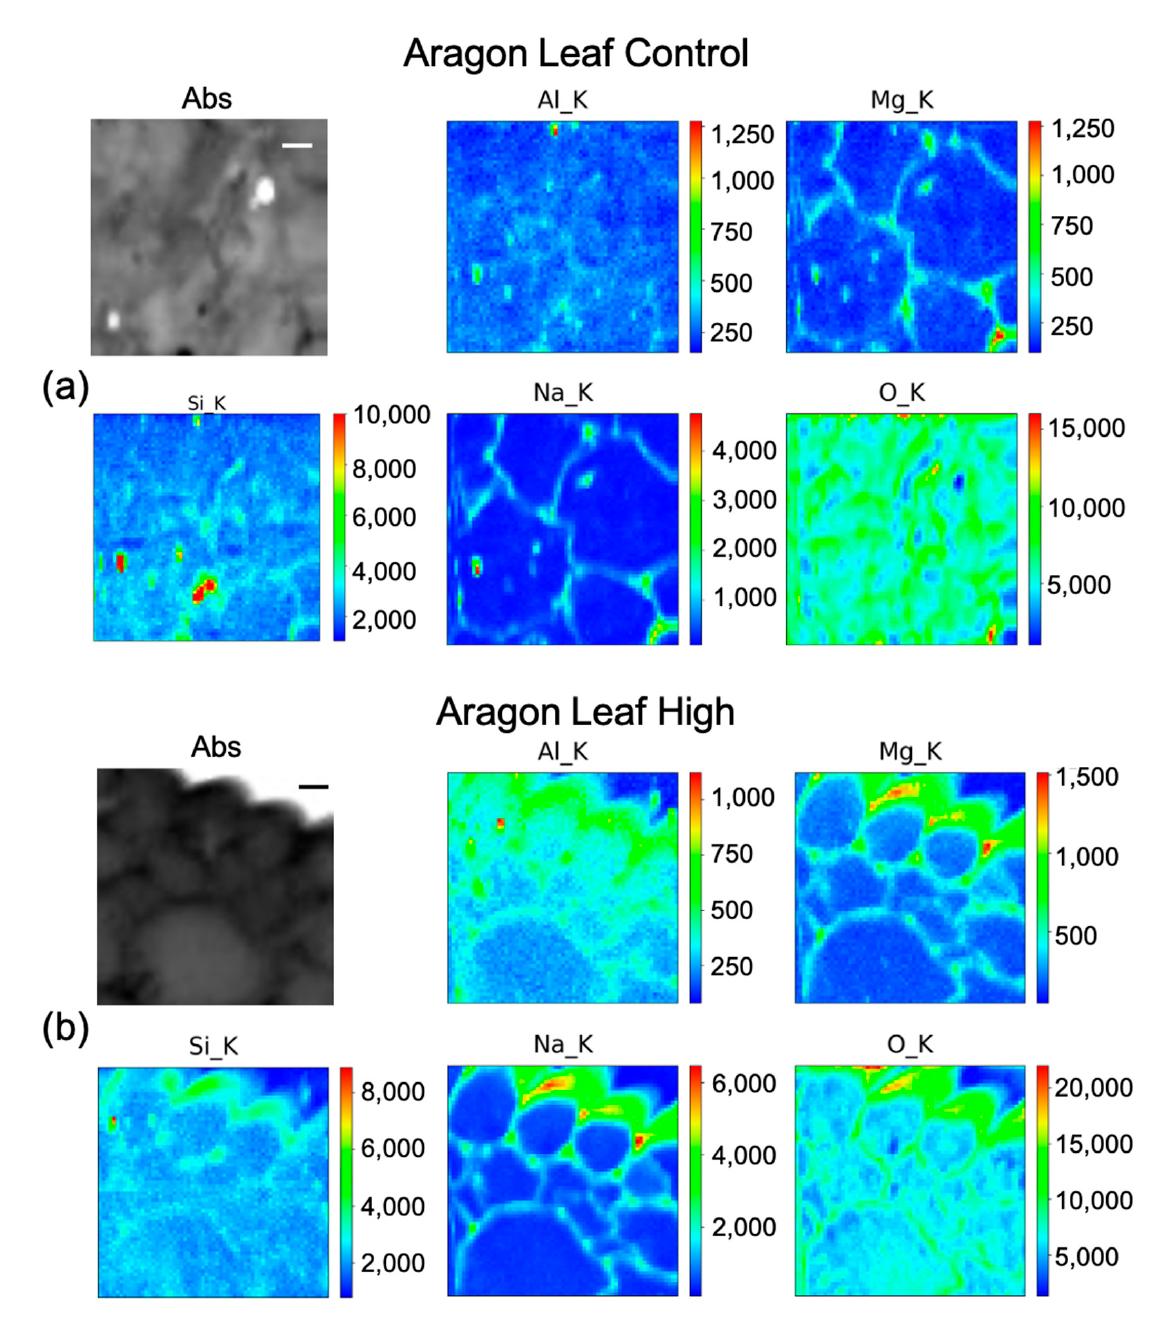
Figure 7. Micro-X-ray Fluorescence ( µ -XRF) elemental maps of O, Al, Na, Mg, and Si, depicting the distribution within the cells of ( a ) Aragon Leaf Control, and of ( b ) Aragon Leaf High Si treatment, shown with their corresponding absorption image (Abs). Scale bar is 10 µm.